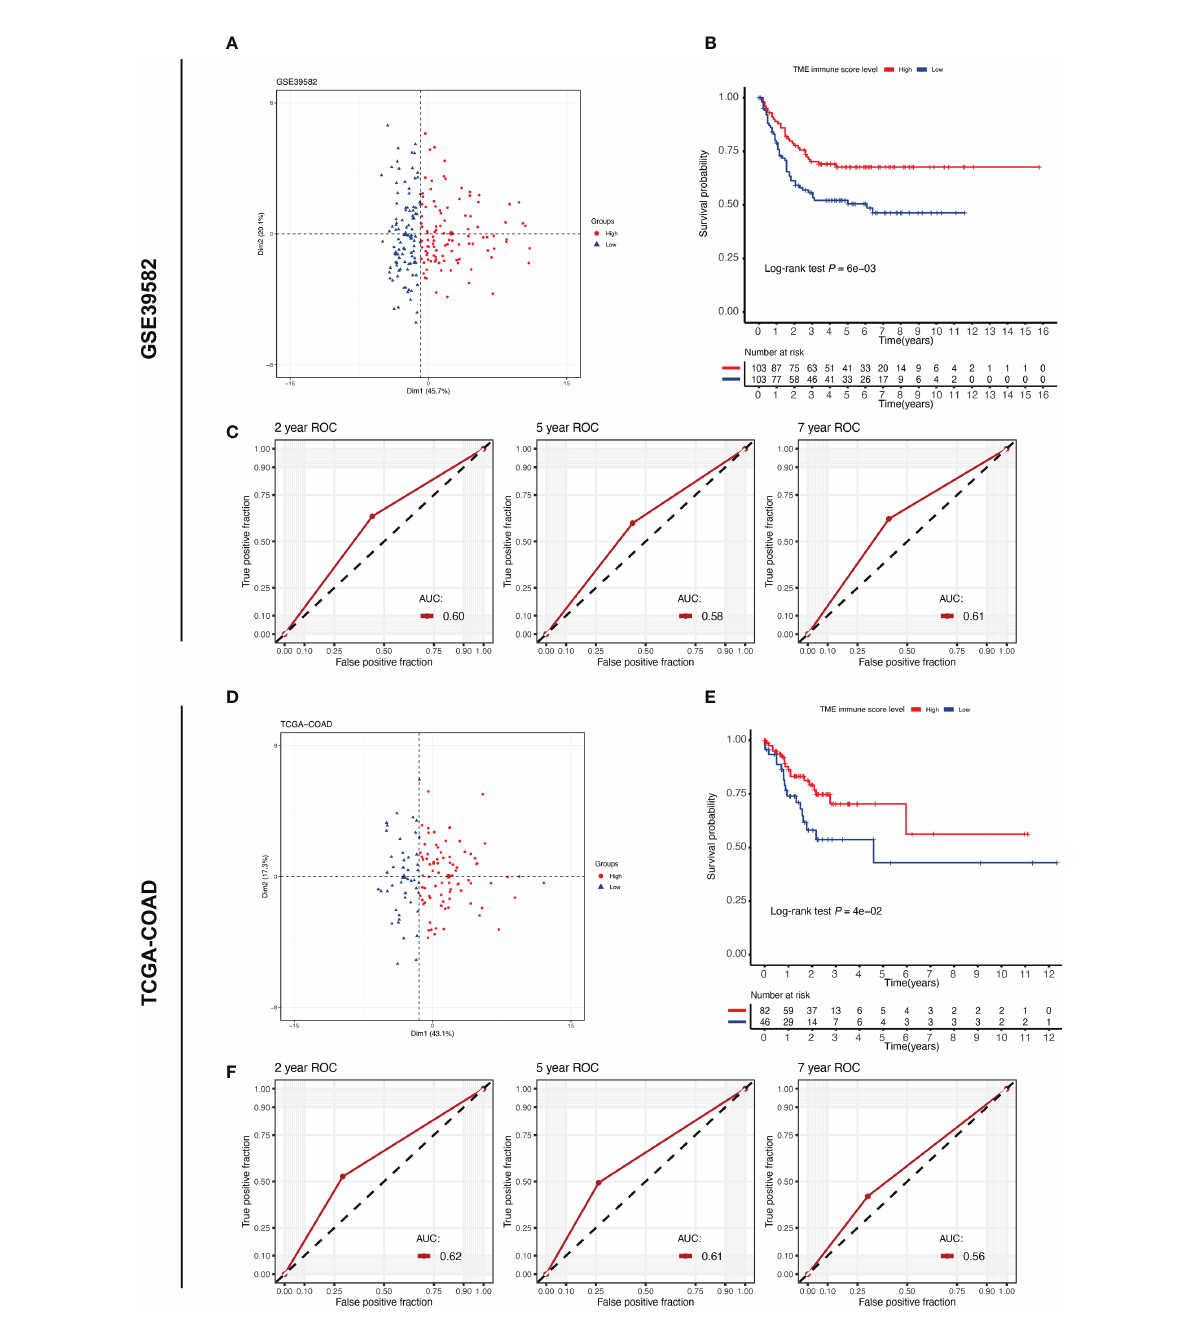
FIGURE 1 TME immune score correlates with the prognosis of patients with stage III CC. TME, tumor microenvironment. (A, D) PCA plot reveals different expression patterns of TME immune score-related genes in different groups of stage III CC patients from the GSE39582 and TCGA-COAD cohorts. (B, E) Kaplan – Meier curves of relapse-free survival according to TME immune score levels in the GSE39582 and TCGA-COAD cohorts. Stage III CC patients with high TME immune scores have a better prognosis (log-rank test P < 0.05) in both datasets. (C, F) The time-dependent ROC curves measuring the predictive power of the TME immune score on 2-, 5-, and 7-year RFS in the GSE39582 and TCGA-COAD datasets. RFS, relapse-free